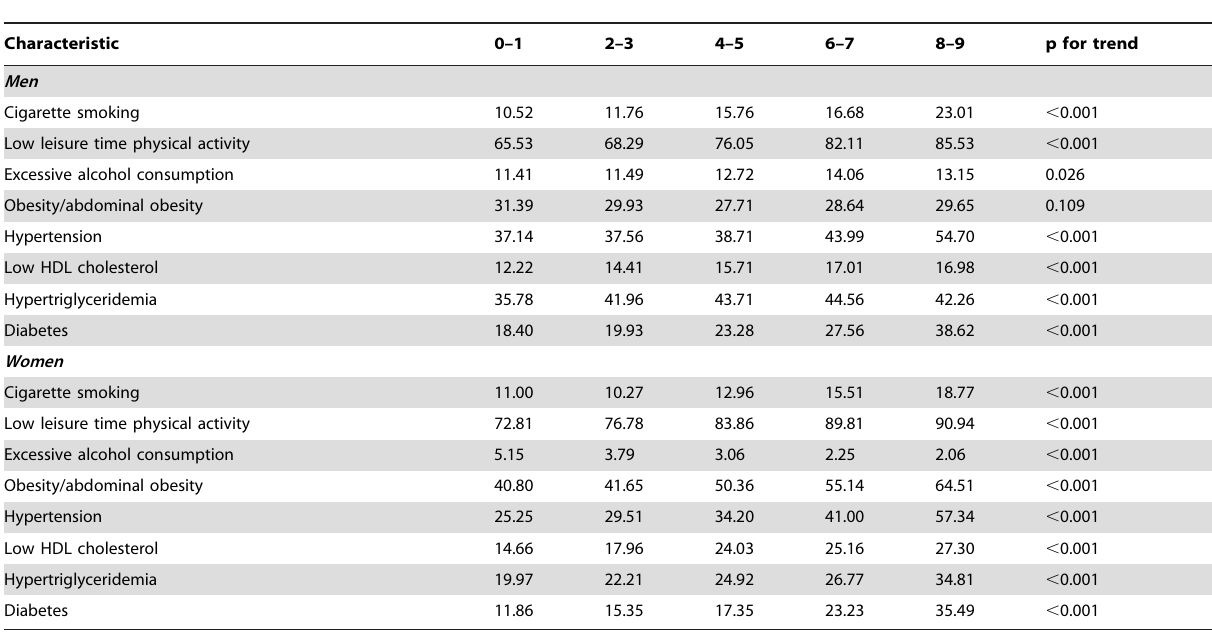
Table 2. Prevalence of health-risk behavior and metabolic alteration according to cumulative socioeconomic position (SEP) score (higher values reflecting worse life course SEP) among men and